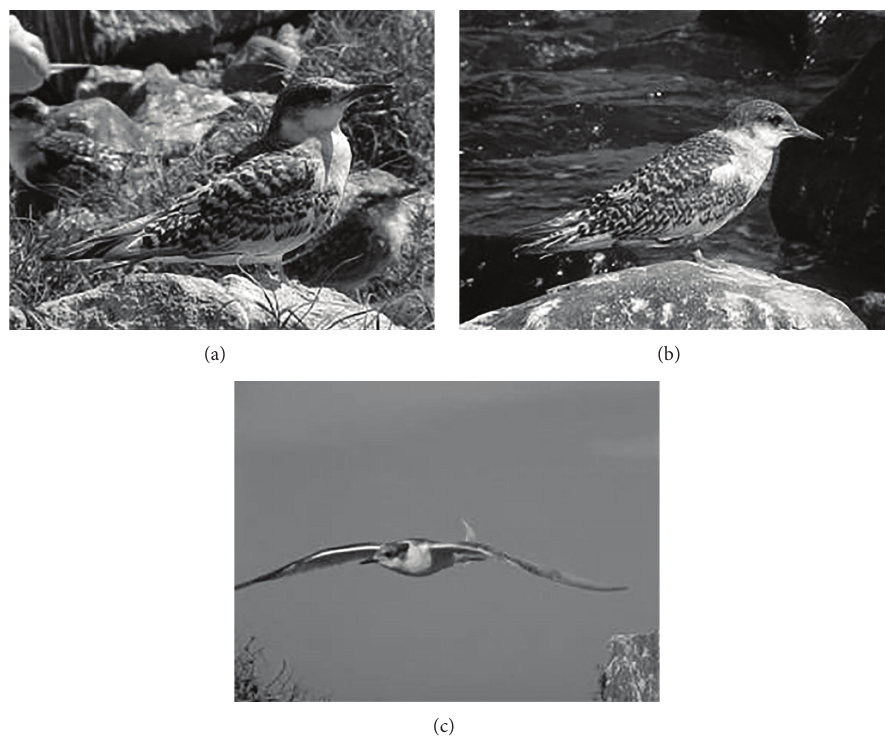
Figure 7: Sterna hirundinacea juvenile perched (a) and (b) and in flight